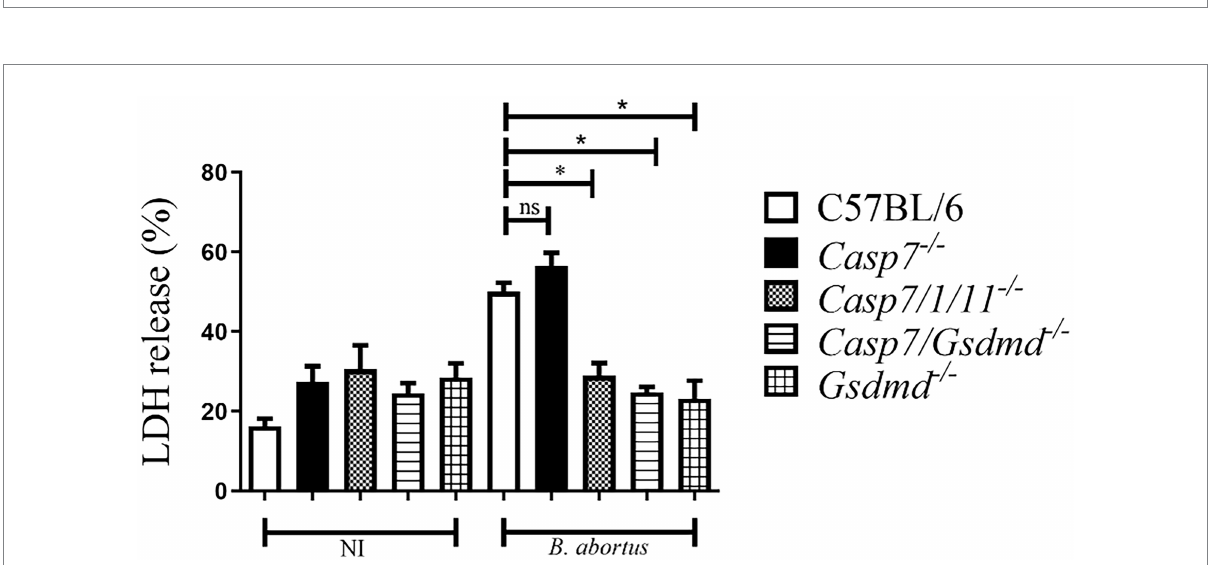
FIGURE 2 Caspase-7 does not participate in macrophage pyroptosis during B. abortus infection. BMDMs were infected with Brucella abortus MOI: 100 for 8 h and LDH quantification was performed in the cell supernatant. Values represent the percentage of LDH released compared to control cells lysed with Triton X-100. The data show the mean ± standard deviation representative of three independent experiments. One-way ANOVA, * p < 0.05 compared to C57BL/6.